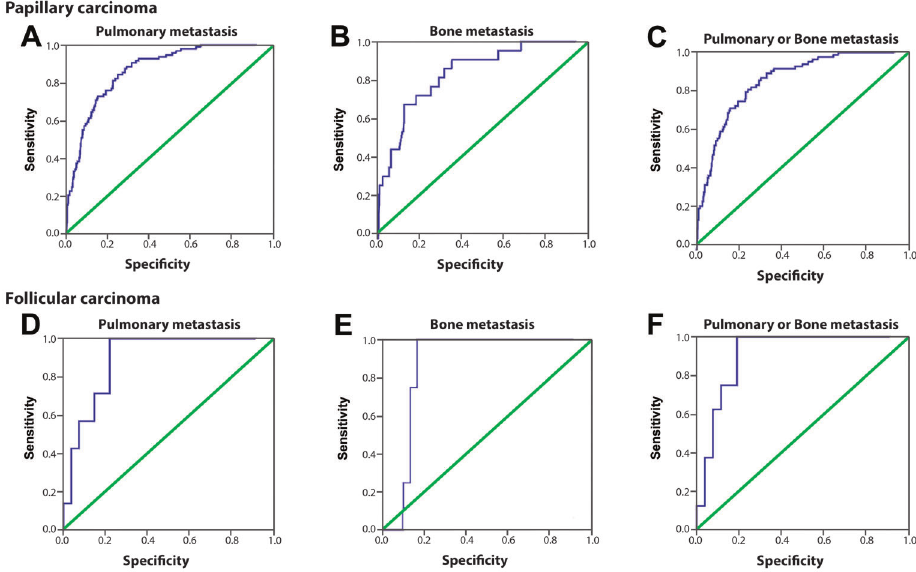
Figure 5. ROC of serum postoperative stimulated thyroglobulin (ps-Tg). A – C , Papillary carcinoma: ROC in identifying the presence of A , pulmonary metastasis; B , bone metastasis; and C , either pulmonary or bone metastasis. The area under the curve (AUC) was 0.841 (pulmonary), 0.834 (bone), and 0.849 (pulmonary and bone). D – F , Follicular carcinoma: ROC in identifying the presence of D , pulmonary metastasis; E , bone metastasis; and F , either pulmonary or bone metastasis. The AUC was 0.886 (pulmonary), 0.857 (bone), and 0.901 (pulmonary or